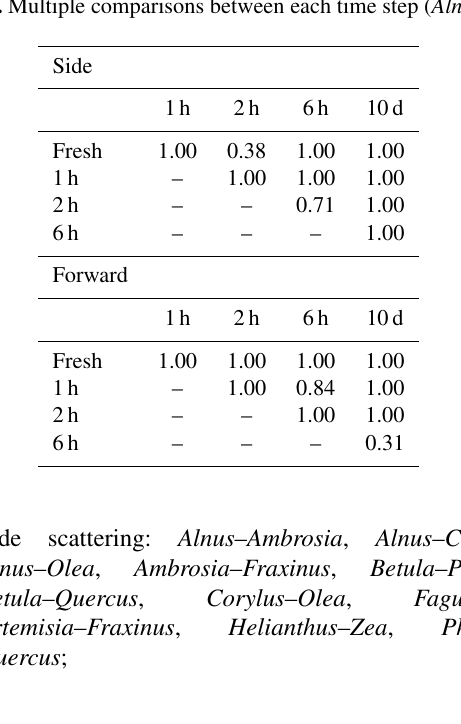
Table 1. Multiple comparisons between each time step ( Alnus